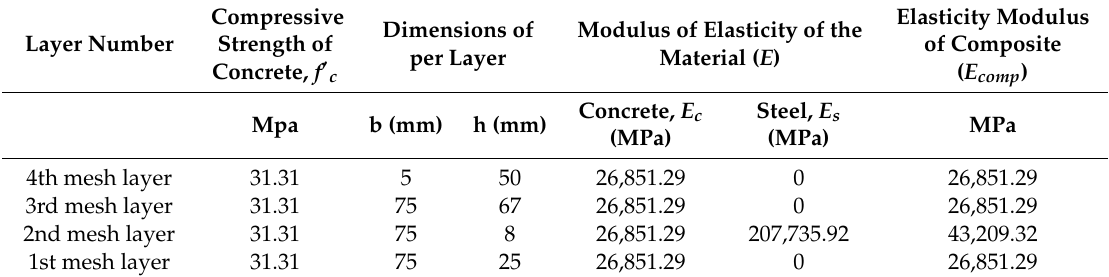
Table 4. Elasticity Modulus of Composite of SRC